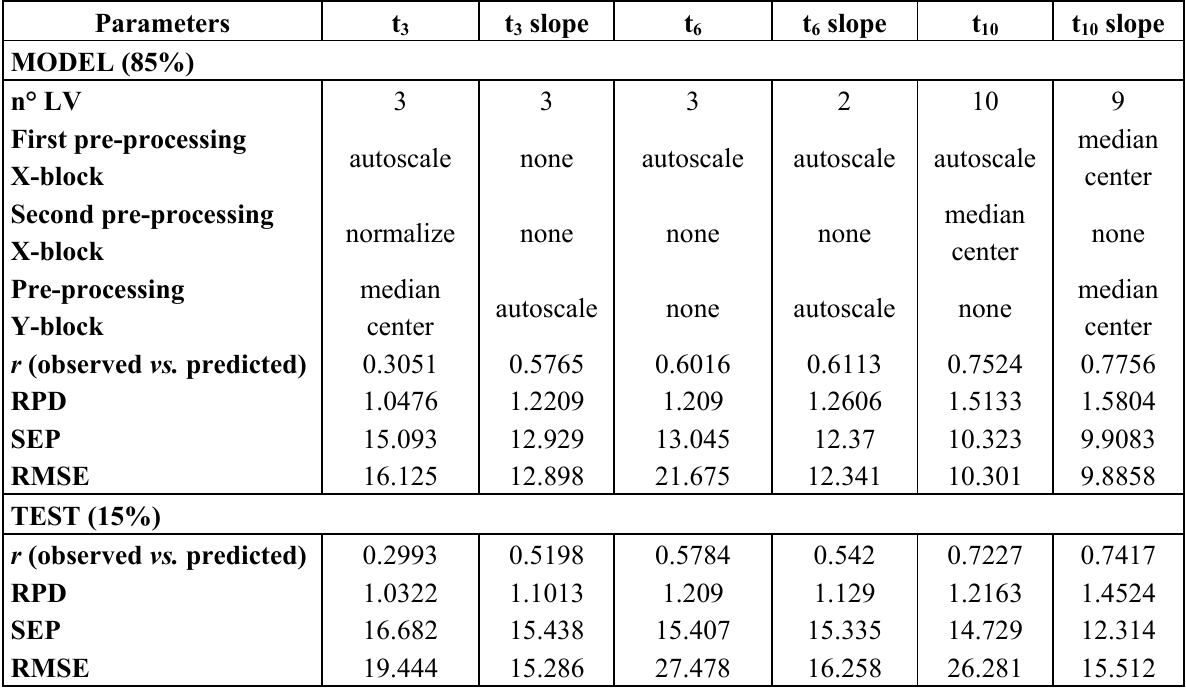
Table 2. Partial Least Squares (PLS) results for the prediction of soil water content